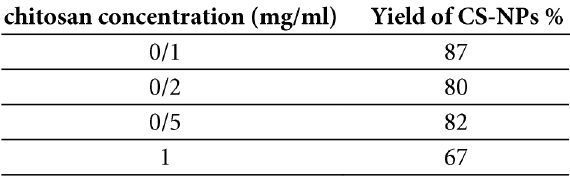
Table 2. Yield of Chitosan Nanoparticles% were prepared by using of TPP concentration of 0.5